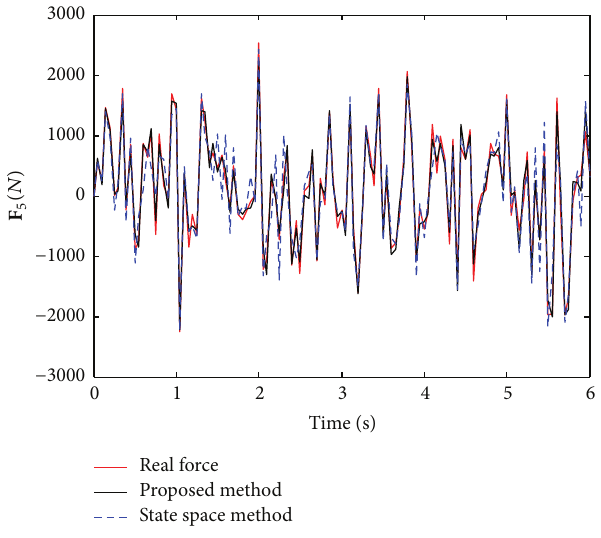
Figure 10: Force identification results of F 5 .